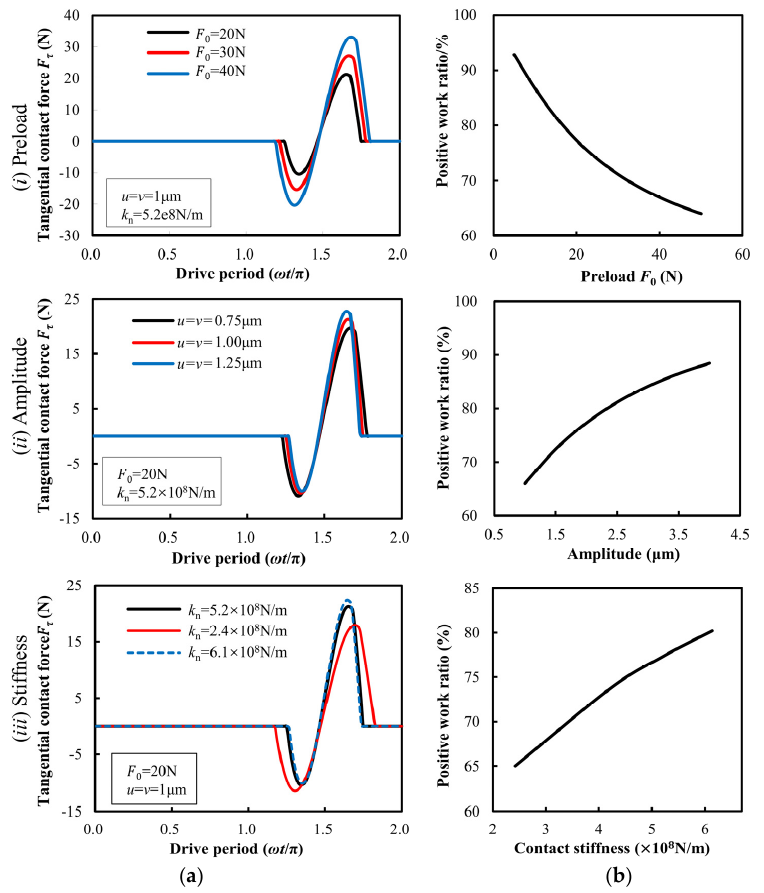
Figure 9. Tangential contact force between stator and slider and its proportion of positive work under different conditions. ( a ) Tangential contact force, and ( b ) positive work ratio. During a friction-driving period of the stator/slider, the tangential contact force be- tween the stator is shown in Figure 10. It can be seen from the diagram that there is a significant difference in the tangential force calculated by the Coulomb model and the Dahl model at any time in the contact stage. At the same time, there is a sudden change in the tangential contact force between the stator based on the Coulomb model. In the driv- ing period of the stator, the contact process of the stator is continuous. The continuous change of the contact state does not tend to cause the abrupt change of the tangential con- tact force, but the tangential contact force between the stators based on the Dahl model is continuous. Compared with the Coulomb friction model, the friction drive model based on the Dahl friction theory is more consistent with the actual contact condition of the stator and slider.